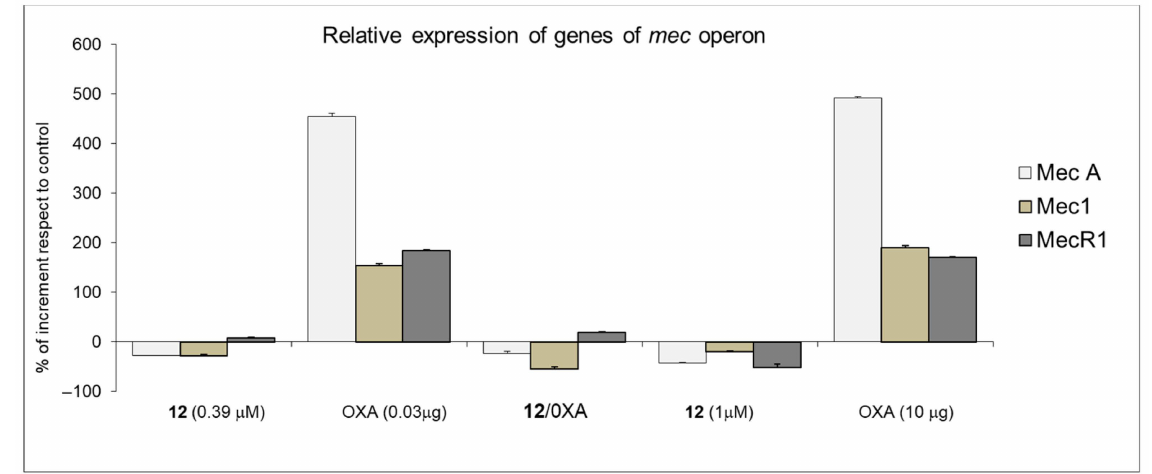
Figure 4. Relative expression of the genes of mec operons. S. aureus ATCC 43300 was treated with subinhibitory concentra- tions of 12 (0.39 µ M) and oxacillin (OXA) (0.03 µ g/mL) for 30 min. Transcript levels were monitored by RT-PCR. The data are presented as the fold change in gene expression normalized to an endogenous reference gene (16 S) and relative to the untreated. Values represent the mean ± SD for three independent experiments.